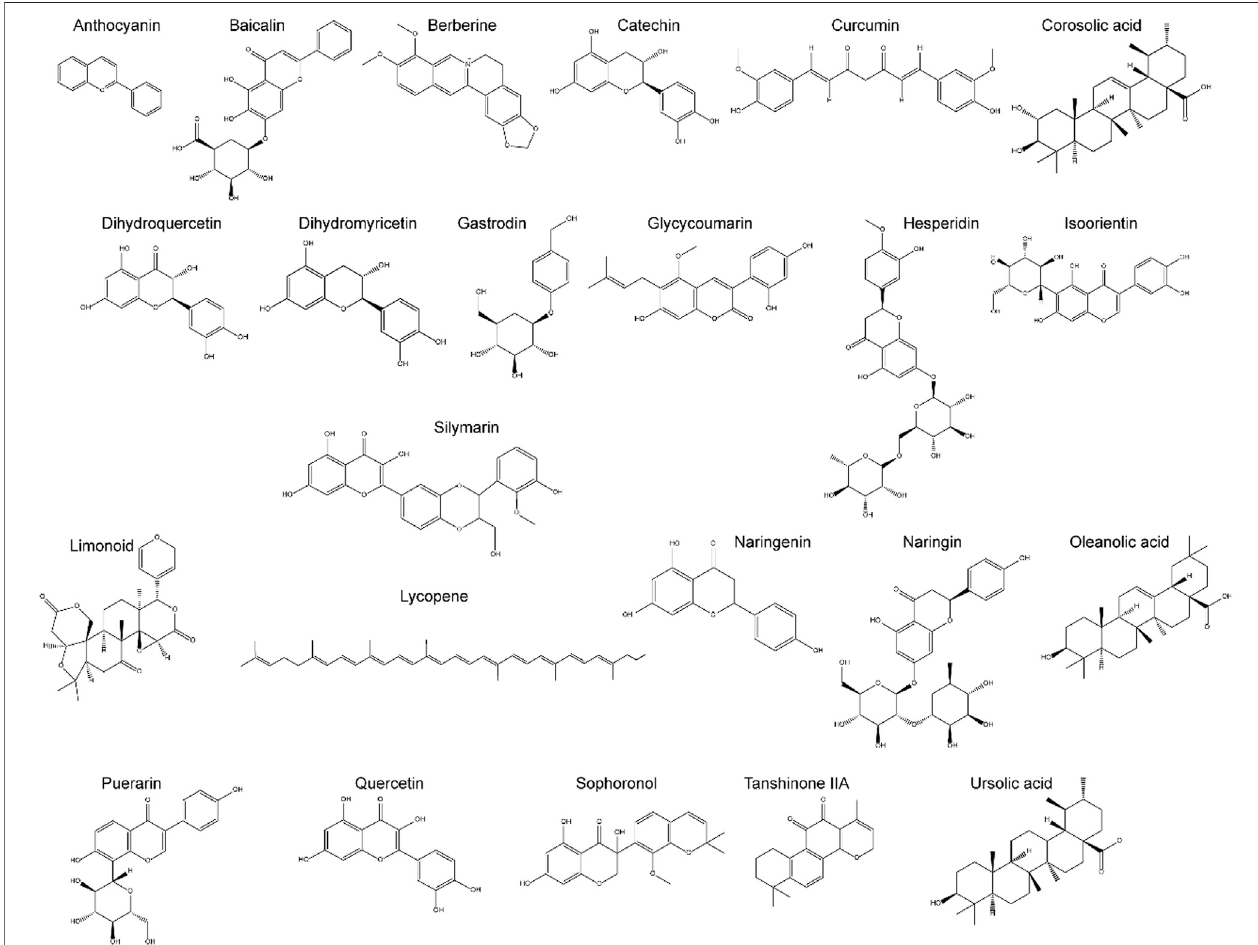
FIGURE 3 | The chemical structure of Natural components for the potential treatment of ALD.